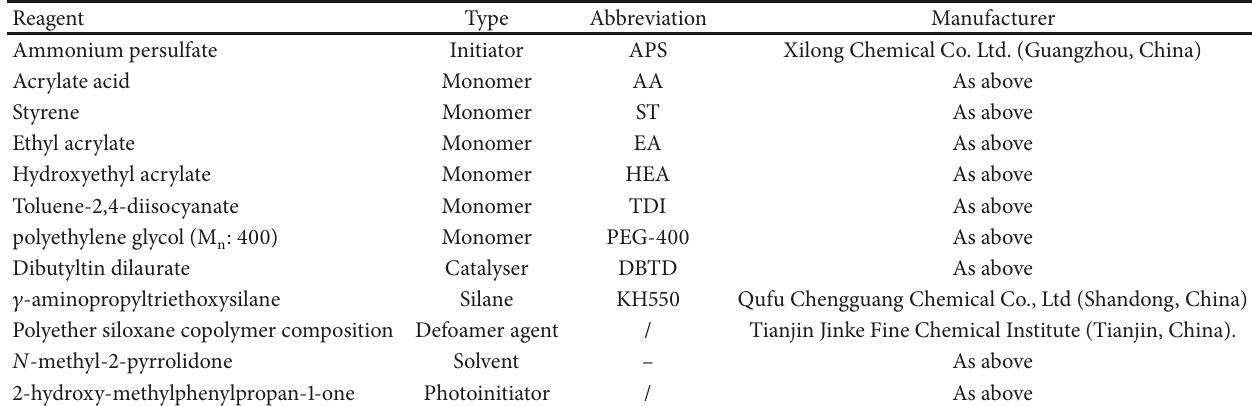
Table 1: Reagents for water-based PUA